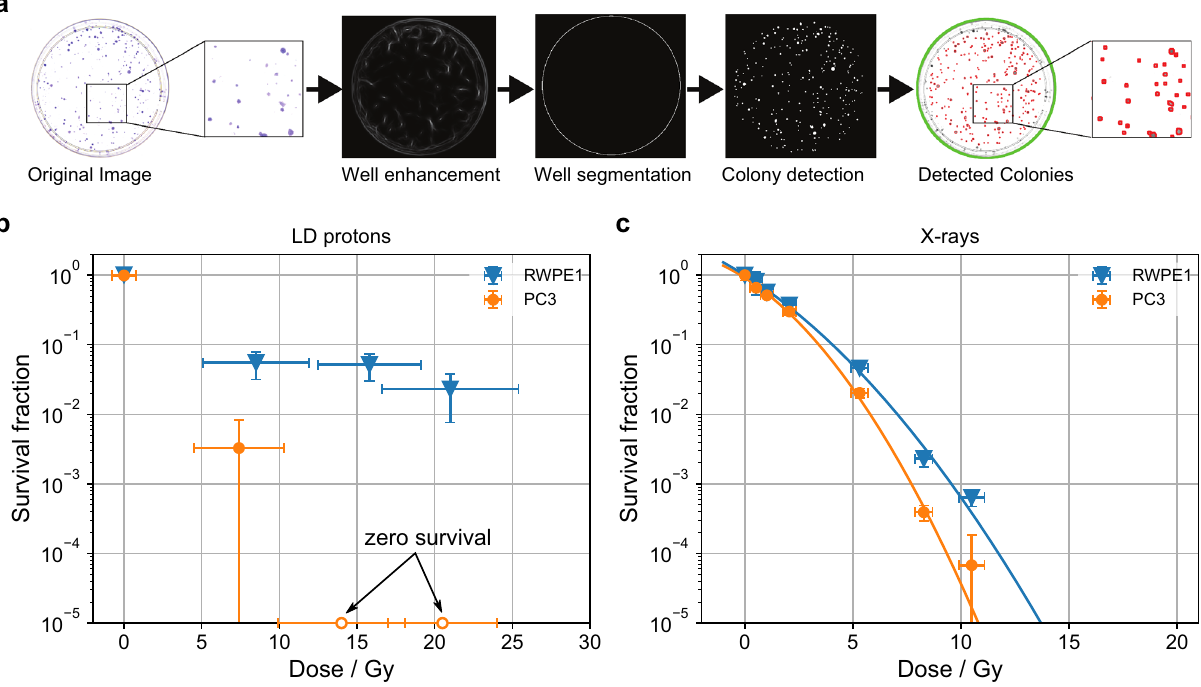
Figure 4. Cell survival fraction based on clonogenic survival. ( a ) Quantitative pipeline for automatic colony quantification. ( b , c ) Cell survival fraction based on clonogenic survival of human prostate cancer cells (PC3, orange markers) and normal adult human prostate cells (RWPE1, blue markers) after irradiation with laser- driven protons ( b ) and low dose rate X-rays ( c ). Survival fractions represent the ratio of the plating efficacy of the irradiated cells to unirradiated cells. Error bars of the survival fractions are the standard deviation across two independent experiments, where cell samples were irradiated in triplicate per dose group. Dose error bars contain average non-uniformity in terms of the standard deviation of the lateral dose distribution for each sample, the sample-to-sample variation (standard deviation) within one dose group and the uncertainty arising from the film calibration. Open circles (PC3 only) indicate a survival fraction of zero. An orthogonal distance regression fit with model function y = c·exp(− a·x − b·x 2 ) was applied to the X-ray survival fractions. The resulting fit parameters for RWPE1 are c = (0.998 ± 0.029), a = (0.452 ± 0.060), b = (0.028 ± 0.008) and for PC3 are c = (0.917 ± 0.069), a = (0.456 ± 0.081), b = (0.056 ±